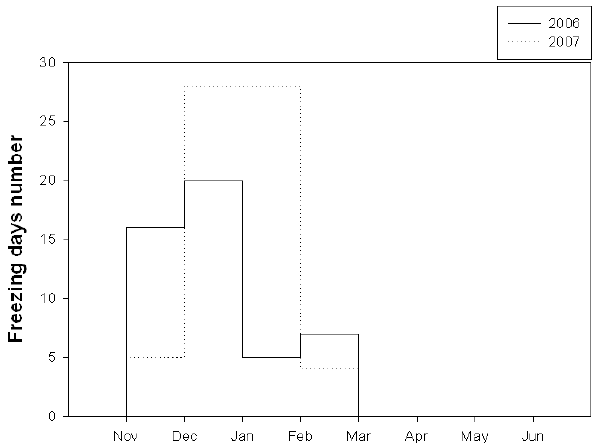
Fig. 4. Freezing days number during growth period of cumin in 2006 and